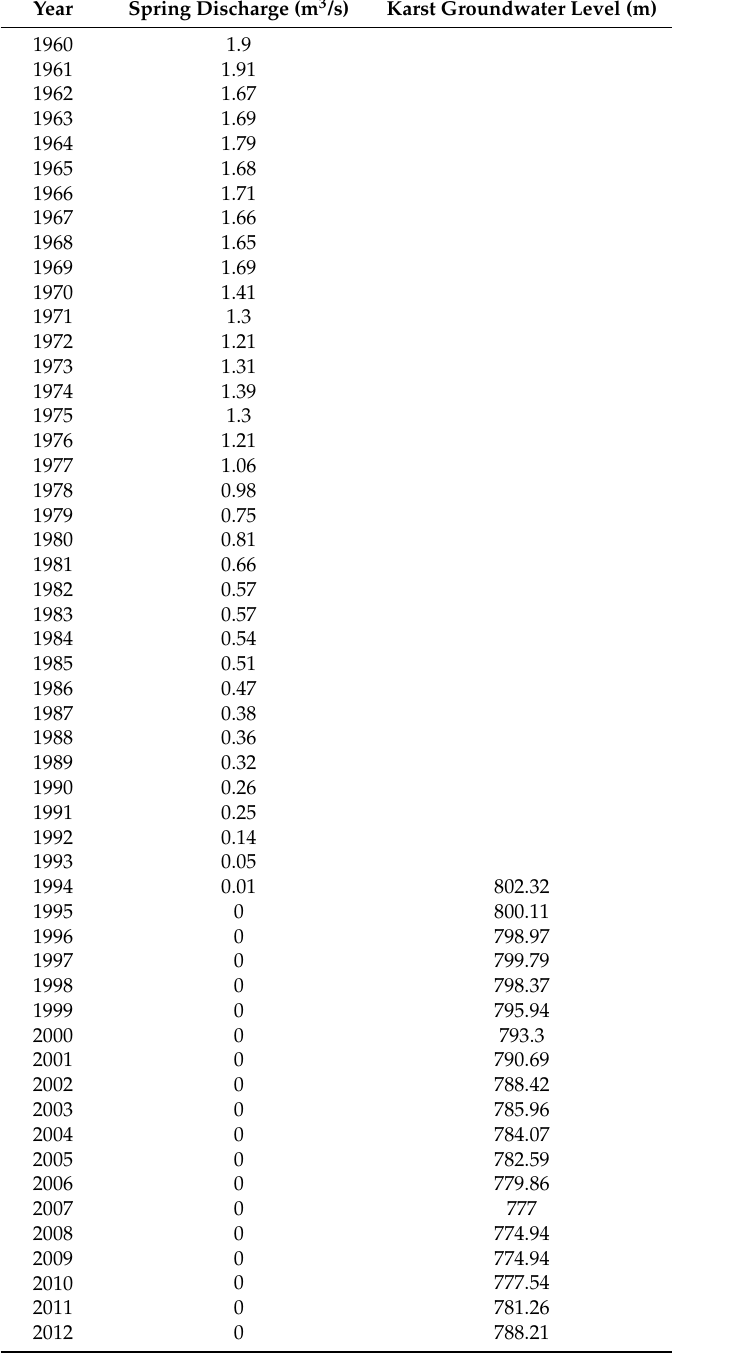
Table A1. The data of spring discharge and karst groundwater